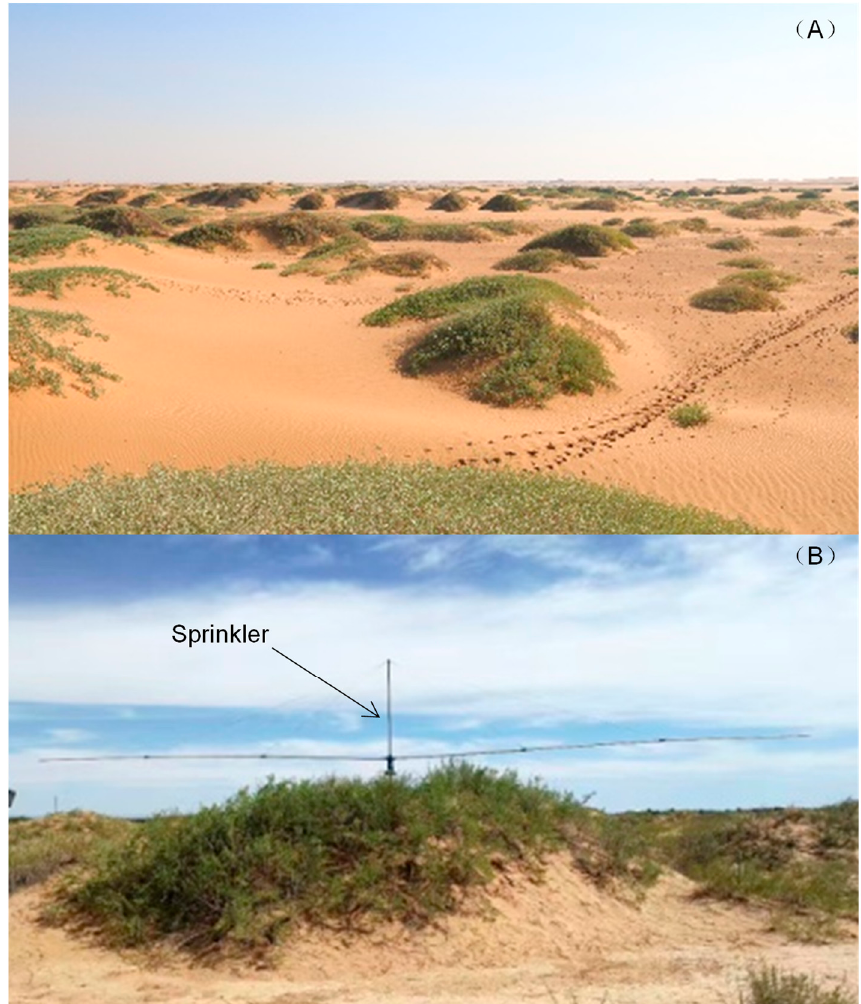
Figure 1. Nitraria tangutorum desert ecosystem of the study site ( A ) and sprinkler on sandbags (( B ) [18]) in Inner Mongolia, China .